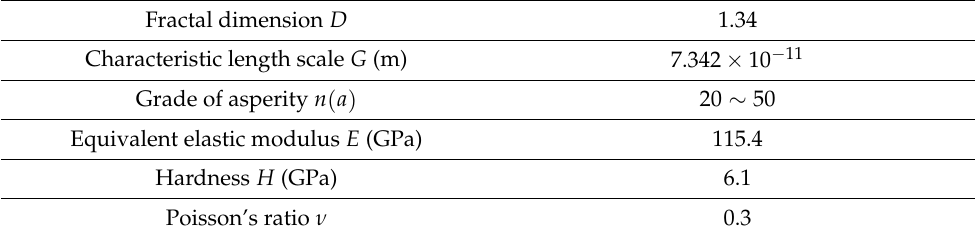
Table 1. Model parameters of the rough